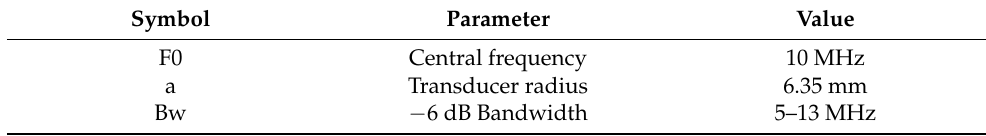
Table 2. Parameters of the bolt specimens.